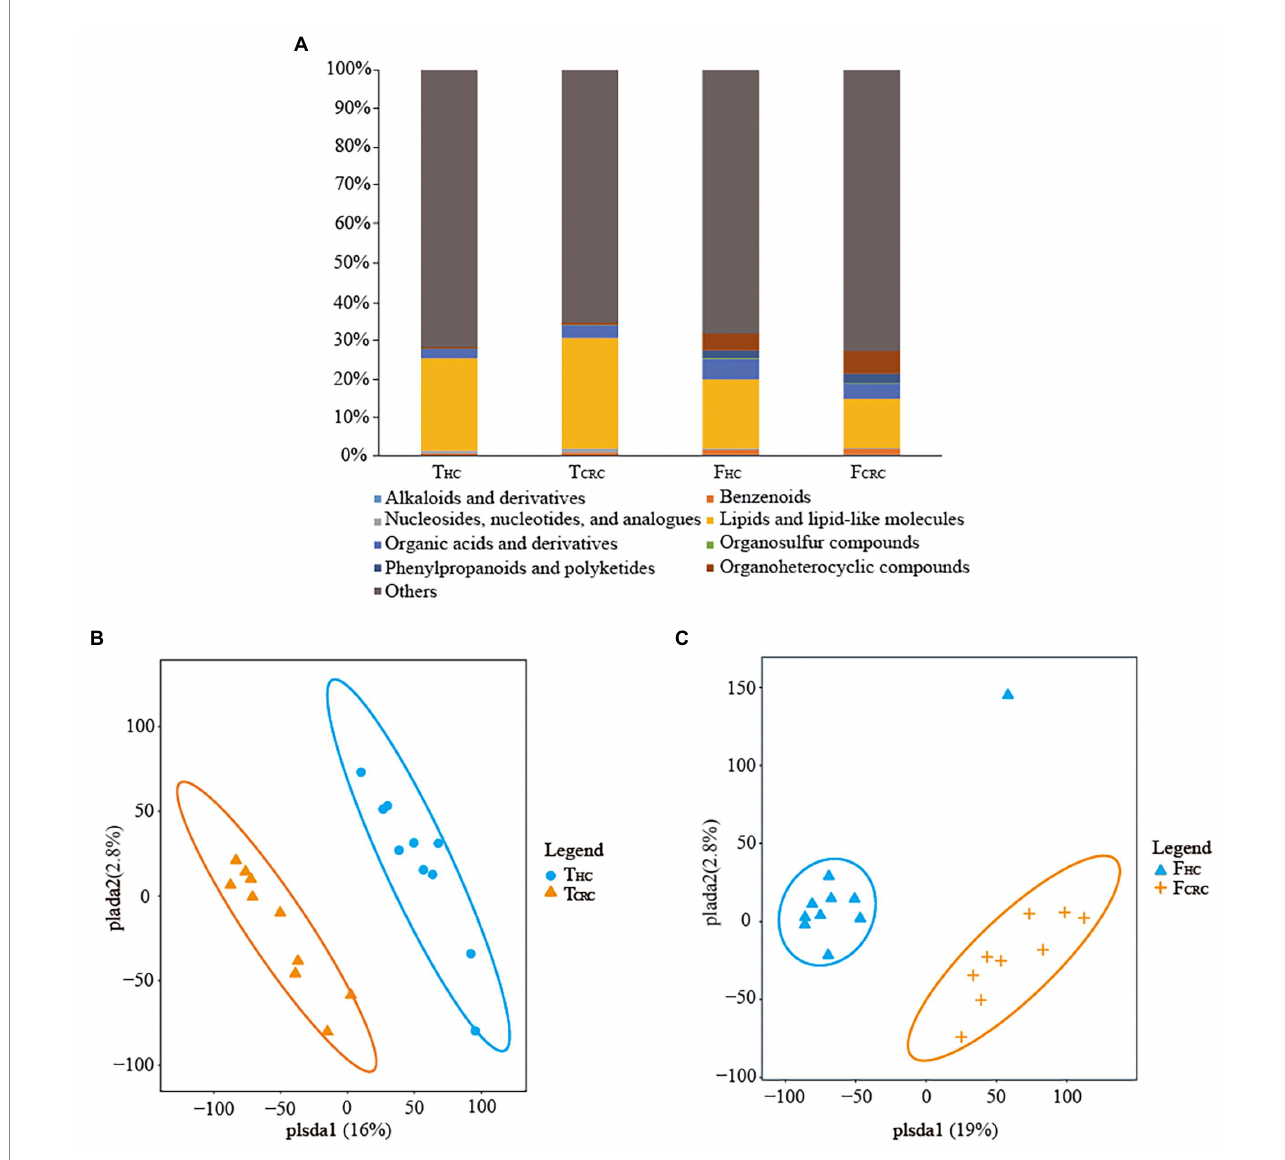
FIGURE 3 Compositions of metabolites between the T HC and T CRC groups, and between the F HC and F CRC groups (A) . PLS-DA score plots differentiating samples based on metabolites comparing the T HC and T CRC groups (B) , and between the F HC and F CRC groups (C) ,